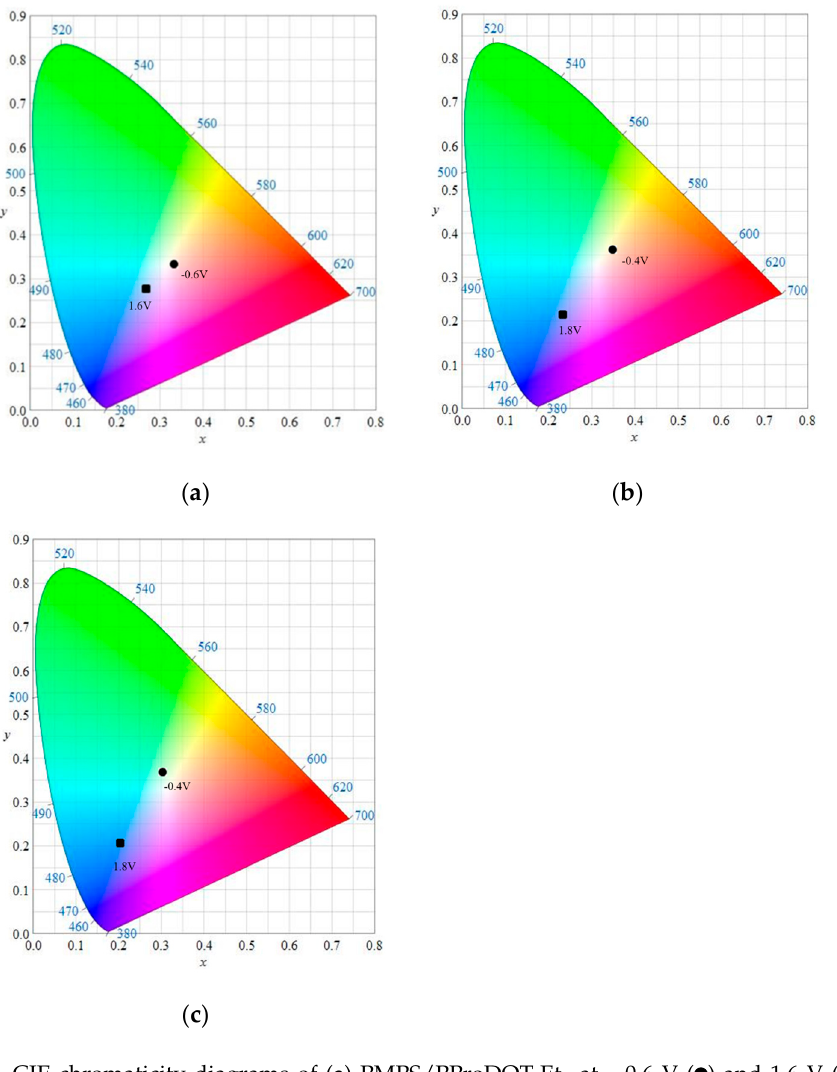
Figure 8. CIE chromaticity diagrams of ( a ) PMPS/PProDOT-Et 2 at − 0.6 V ( ● ) and 1.6 V ( ■ ); ( b ) PMPO/PProDOT-Et 2 at − 0.4 V ( ● ) and 1.8 V ( ■ ); and ( c ) PANIL/PProDOT-Et 2 at − 0.4 V ( ● ) and 1.8 V ( ■ ). Table 4. The colorimetric values ( L , a , b , L* , a* , b* ) and CIE chromaticity values ( x , y ) of PMPS/PProDOT-Et 2 , PMPO/PProDOT-Et 2 , and PANIL/PProDOT-Et 2 ECDs at different applied potentials.